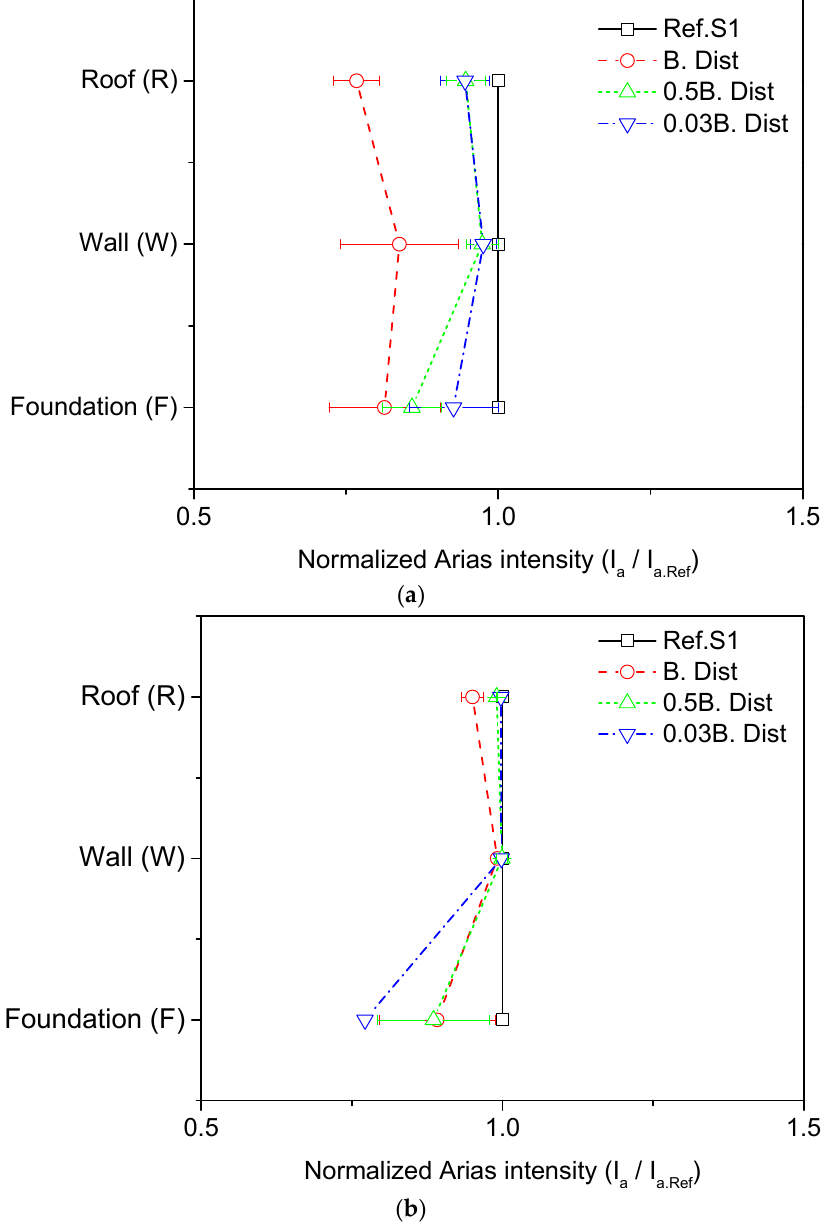
Figure 8. Normalized I a of S1 foundation (F), wall (W), and roof (R) in case of interaction with ( a ) S2 structure and ( b ) S3 structure to I a of S1 structure in the reference case. Average value from two input motions was plotted. Error bars indicate variations of two